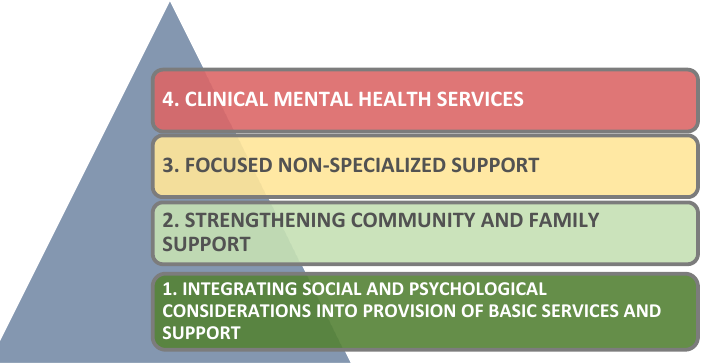
Figure 1. Multi-layered MHPSS services and supports ( 2021, [19] p. 3). Layer 1 (dark green in Figure 1) initiatives aim to provide basic services and security.